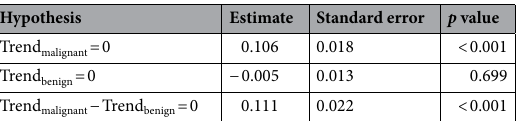
Table 2. Trend estimation and difference in trend of LCP CNN scores overtime (on a square root scale).